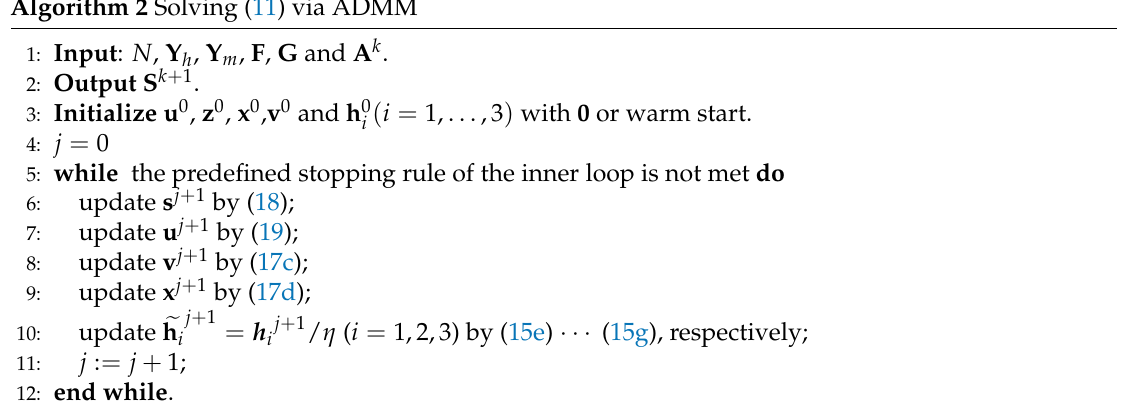
Algorithm 2 Solving (11) via